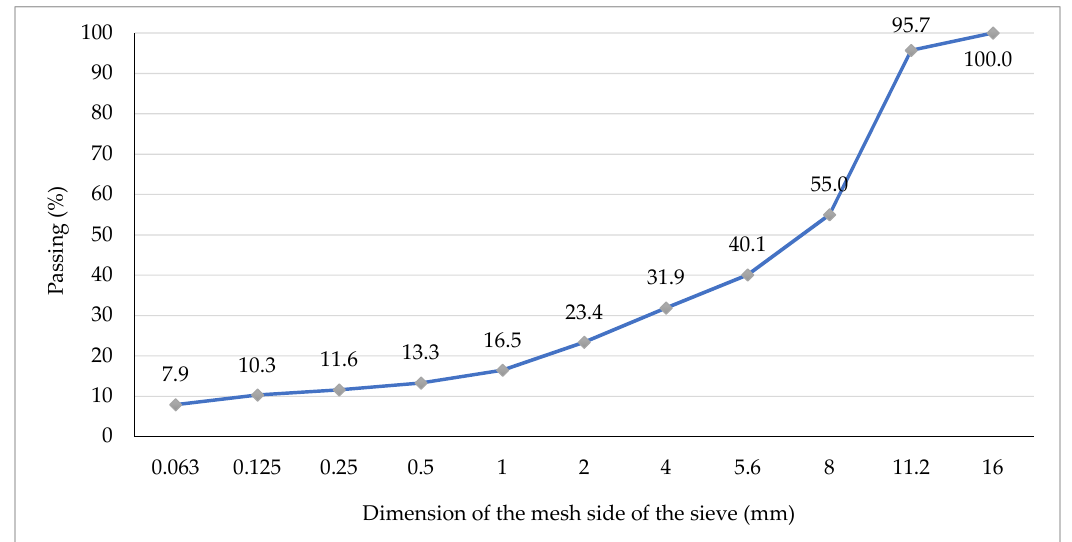
Figure 3. Graph of grain size distribution curve of the SMA11 mixture.